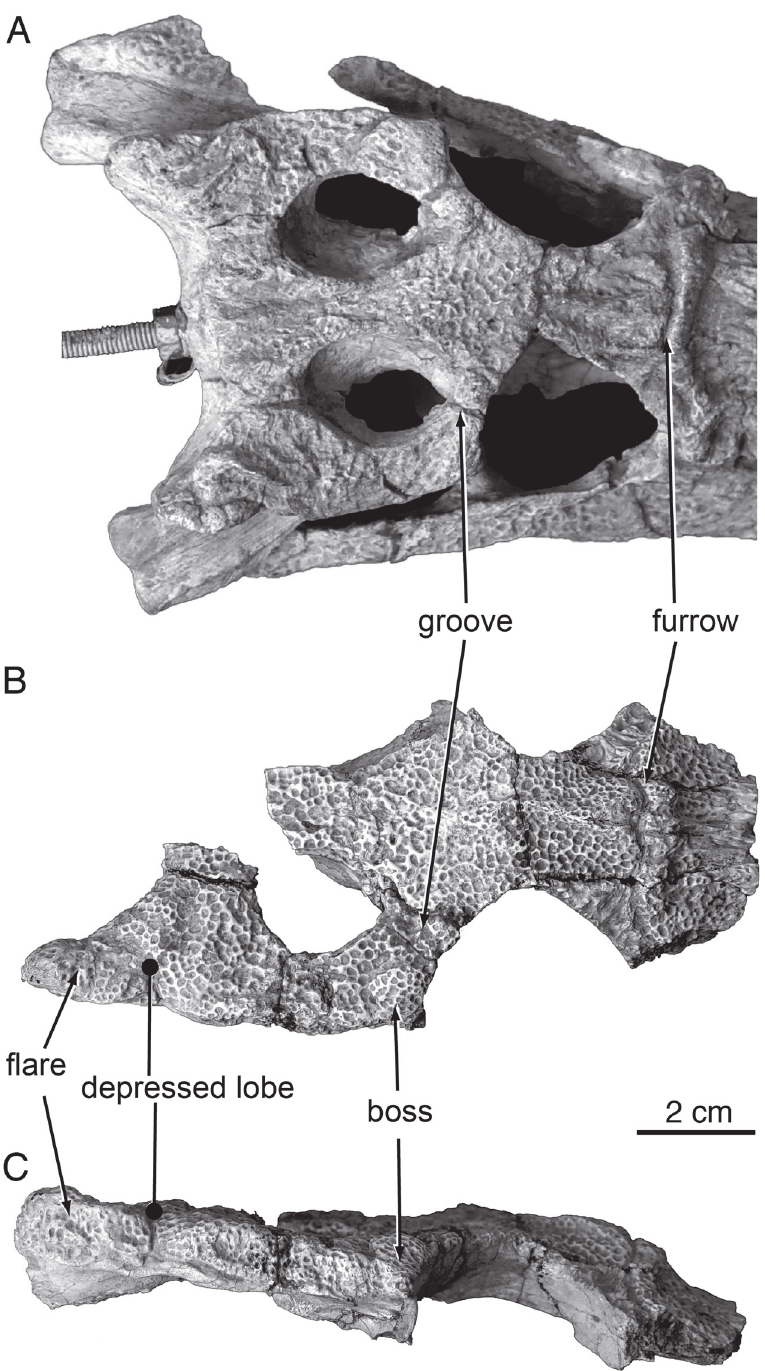
Fig 7. Skull morphology in Paralligatoridae. A , Shamosuchus ulanicus (= Paralligator gradilifrons ) (PIN 3140-502), dorsal view; B , S . ancestralis , (= Paralligator gradilifrons ) (PIN 551-29/1), dorsal view; C , S . ancestralis , (= Paralligator gradilifrons ) (PIN 551-29/1), left lateral